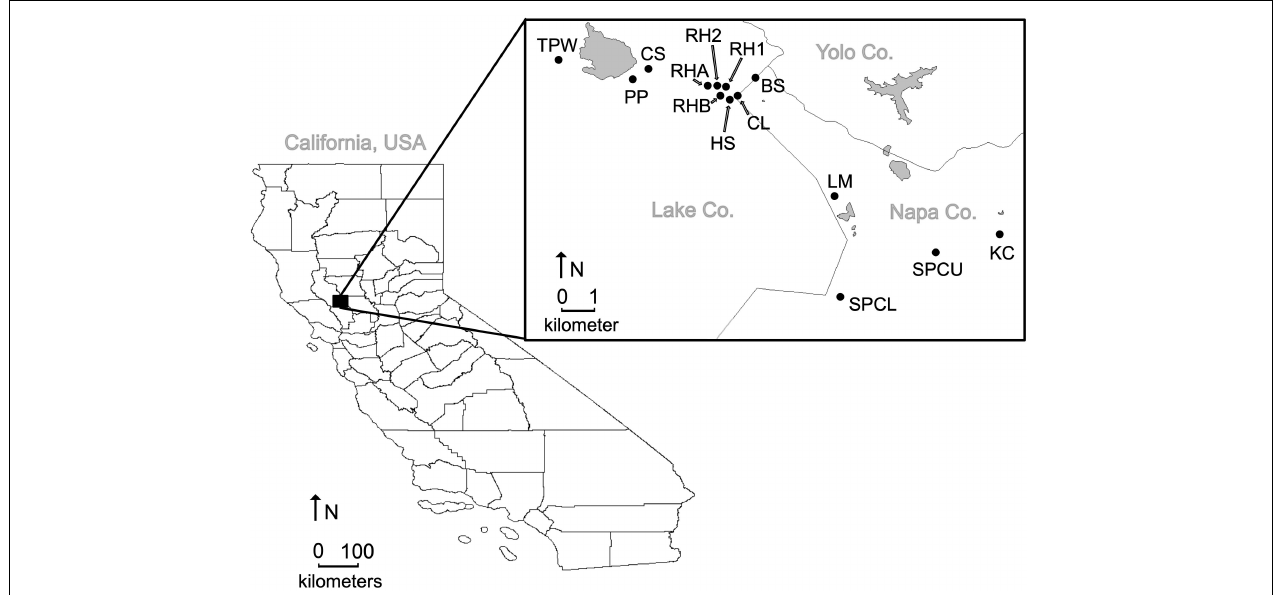
FIGURE 1 | Spatial distribution of serpentine seep communities (black circles) at McLaughlin Natural Reserve in Lake and Napa Counties, California, United States. Gray polygons represent bodies of